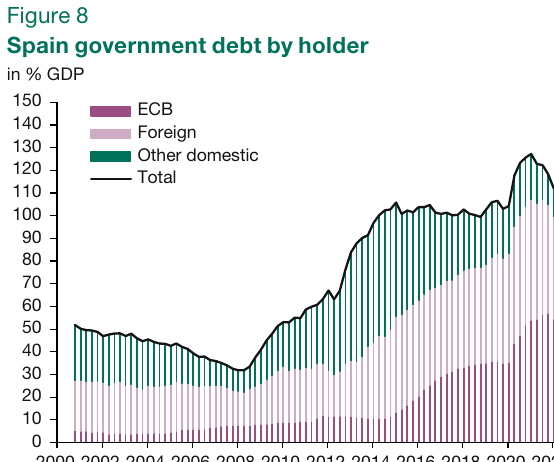
Foreign ownership of government bonds, Q3 2011 vs. Foreign ownership of government debt across all